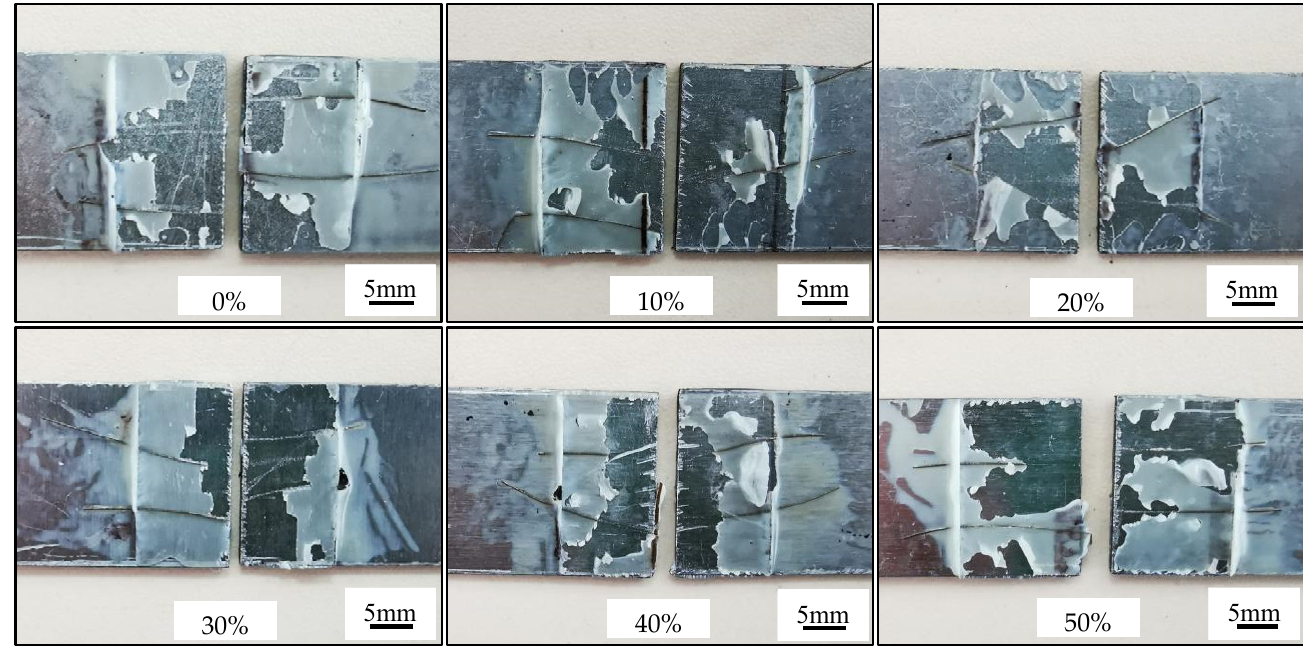
Figure 8. Lap shear strength testing of AS60/60 coating at different reduction ratios.